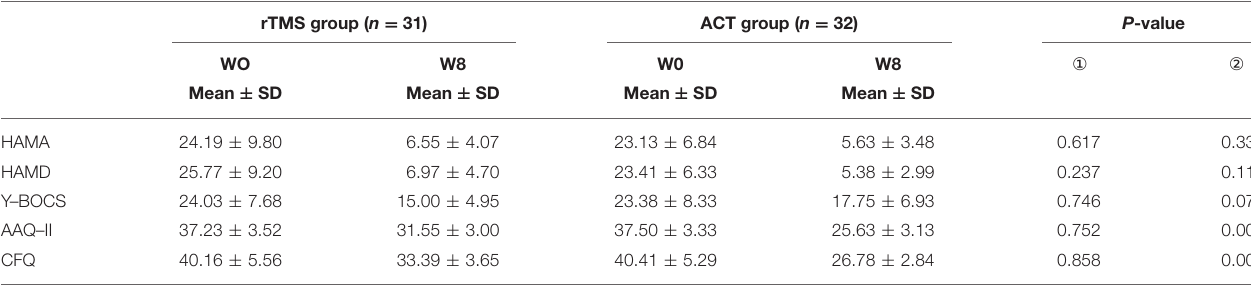
TABLE 3 | Comparison of anxiety, depression, OCS, and psychological flexibility in different groups. rTMS group ( n = 31) ACT group ( n = 32) P -value